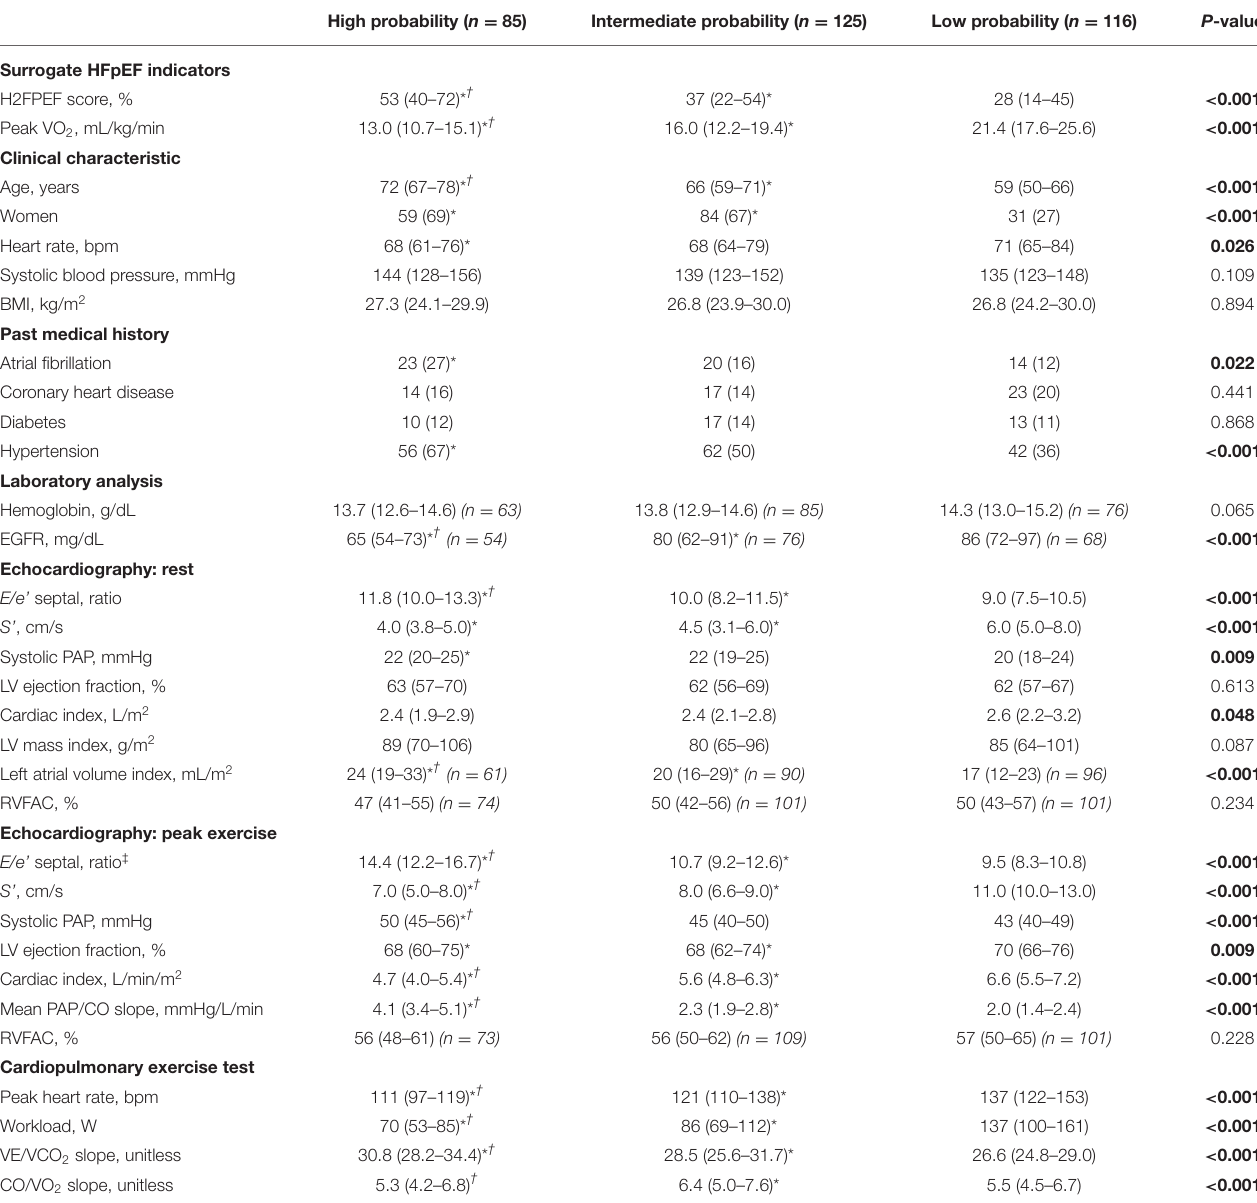
TABLE 2 | Clinical characteristics and measurements in DST cohort, stratified according HFpEF probability (decision tree). High probability ( n =